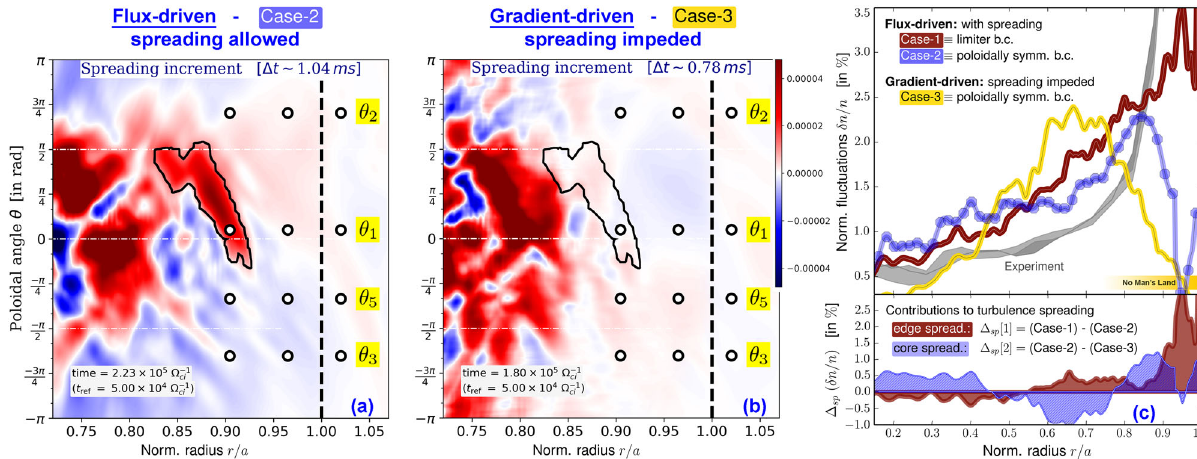
Fig. 4 How forcing and interplay with boundaries impact redistribution of turbulence activity and globally affect transport. Spreading increments for Case-2 ( a ) and Case-3 ( b ) at time t ref ¼ 50 ; 000 Ω (cid:3) 1 ci when both Cases enter nonlinear regime in the edge. A clear shortfall of turbulence activity is visible at statistical equilibrium ( c top) for both Case-2 (purple) and Case-3 (yellow) with respect to experimental (grey) and Case-1 (red) fl uctuation pro fi les δ n / n . ‘ No Man ’ s Land ’ (NMsL) is the region where such shortfalls occur. NMsL, when comparing Case-2 to Case-1 approximately extends between 0.85 ≤ r / a ≤ 1.0. When comparing Case-3 to Case-1, NMsL approximately extends between 0.8 ≤ r / a ≤ 1.0. Differences Δ sp [1] and Δ sp [2], respectively quantify ( c bottom) the importance of turbulent spreading of fl uctuations from separatrix ➝ core and from core ➝